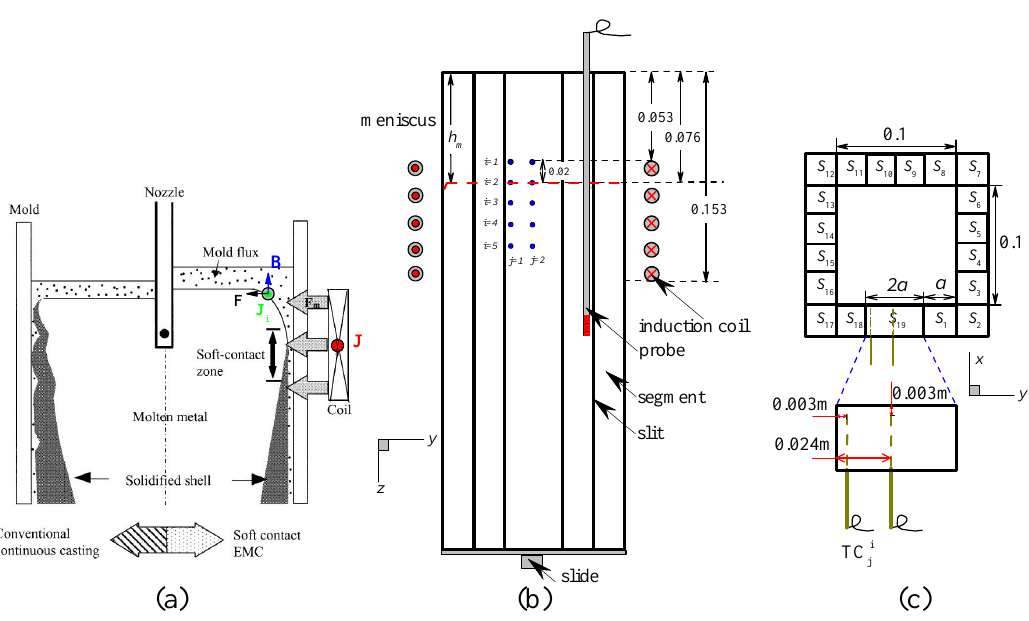
Figure 1. ( a ): basic principles of electromagnetic continuous casting technique [18]; ( b ) and ( c ) are the schematic representations of the experimental facilities from the front view and the top view,